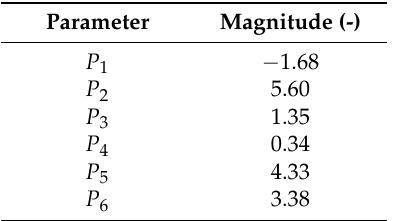
Table 2. Initial wake profile parameters obtained.